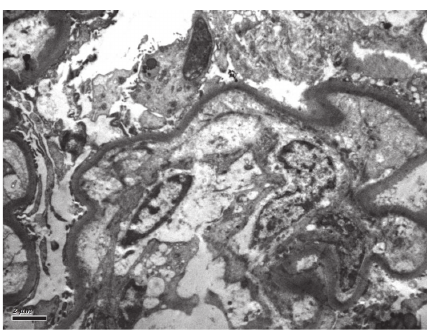
Figure 1: Photograph showing nodular accentuation of glomerular tufts and expanded mesangial areas (PAS × 200).